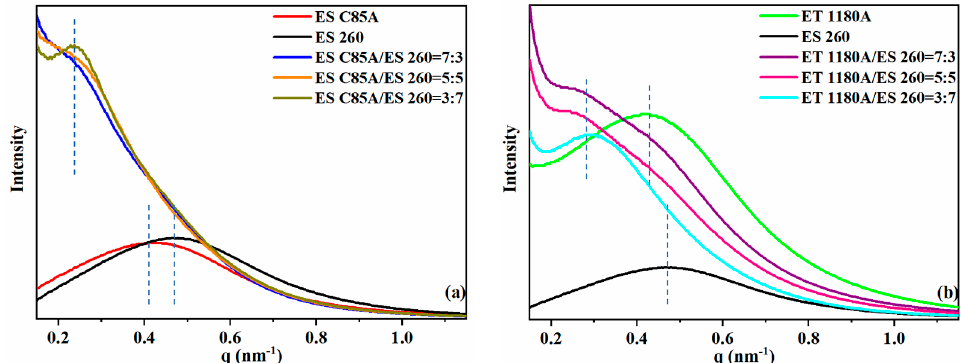
Figure 4. Linear SAXS profiles of neat TPU and TPU blends. ( a ) ESC85A/ES260 blends, ( b ) ET1180A/ES260 blends. The appearance of new imperfect scattering peaks of ( a ) at low angles indicates the formation of a new phase region structures. Relatively ordered scattering peaks ( b ) appear at low angles. The small change of the blends’ scattering peaks compared with the neat TPU indicates the small change of phase structure. The position of the scattering peak is denoted by the blue dotted line.